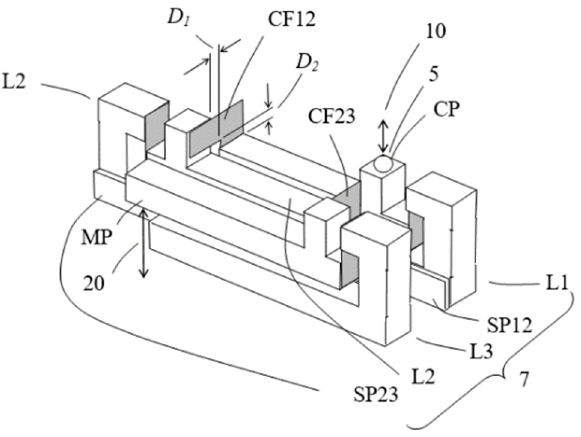
Figure 11. The MDMM conceptual design D.